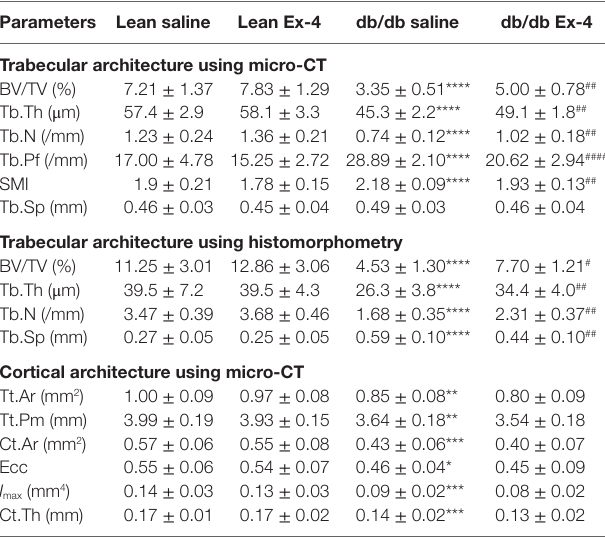
TaBle 1 | Measurements of trabecular and cortical bone architecture in 13-week-old db/db and lean mice treated with either Ex-4 or